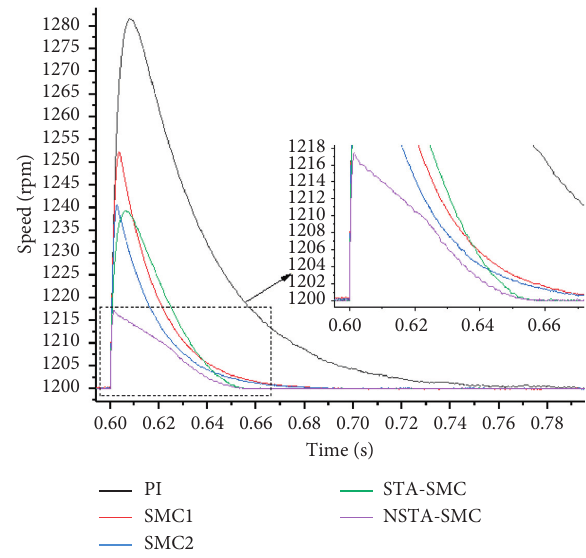
Figure 4: Enlargement of local speed (b).